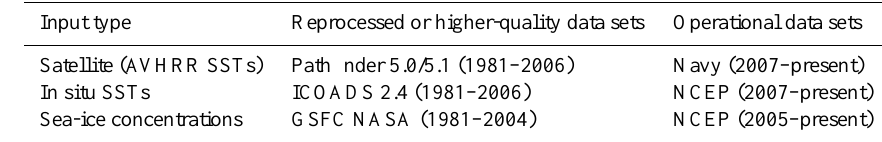
Table 1. Input data sets to the daily OISST version 2. The data sources are explained in detail in Reynolds et al. (2007). For version 1, ICOADS 2.1 was used.